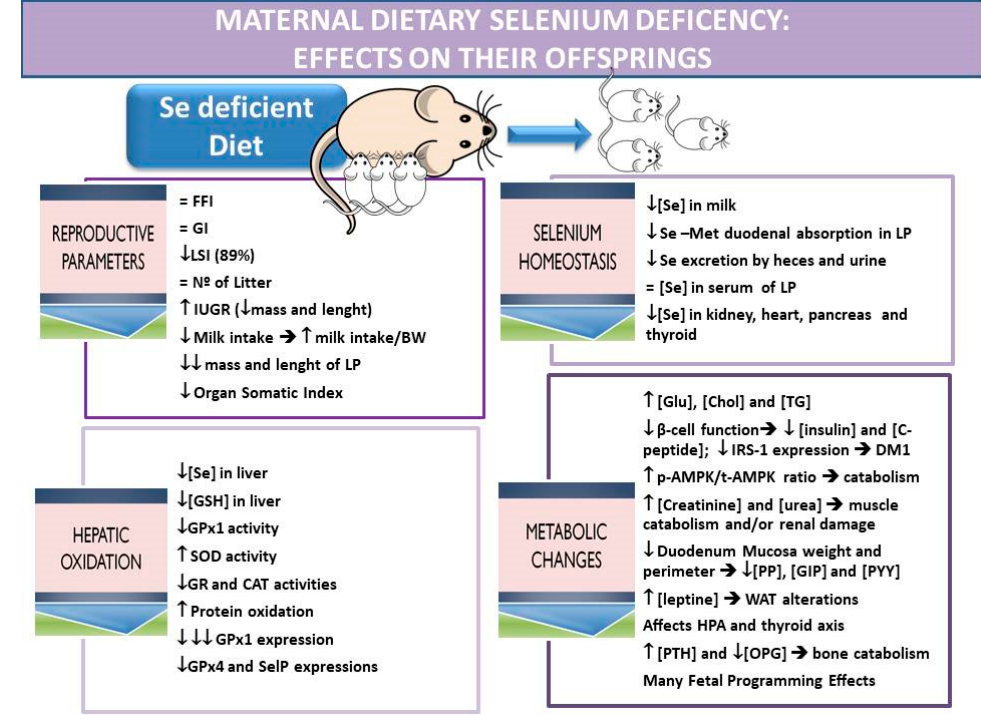
Figure 1. Maternal dietary selenium deficiency: effects on their offspring related to reproductive parameters, selenium homeostasis, hepatic oxidation and metabolic changes. The results are extracted from a Se-deficient dietary experimental model applied to mothers during preconception, gestation and lactation periods carried out by this Research Group. FFI: fertility female index (number of pregnancies/number of mating × 100), GI: gestation index (number of successful births/number of pregnancy rats × 100), LSI: lactation survival index ((number of total offspring—number of died off- spring/number of total offspring) × 100), IUGR: intrauterine growth retardation, BW: body weight, LP: lactating pups, GSH: glutathione, GPx: glutathione peroxidase, SOD: superoxide dismutase, CAT: catalase, GR: glutathione reductase, SelP: selenoprotein P, Chol: cholesterol, TG: triglycerides, Gluc: glucose, IRS-1: insulin receptor sustrate-1, DM1: type 1 diabetes mellitus, HPA: hypothalamic–pituitary–adrenal axis, PP: pancreatic polypeptide, GIP: gastric inhibitory poly- peptide, PYY: peptide YY, PTH: parathyroid hormone, OPG: osteoprotegerin, AMPK: AMP-activated protein kinase, WAT: white adipose tissue.